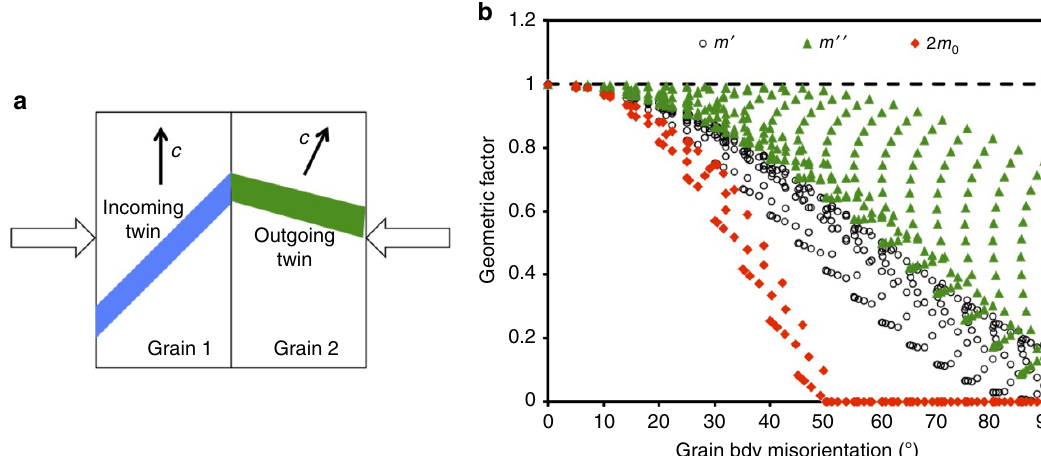
Figure 3 | Characterization of twin transmission using geometric measures. ( a ) Schematic representation of the grains with incoming and outgoing twins with loading direction. ( b ) Geometric factor for twin transmission across grain boundaries for Mg. Three geometric factors are considered: m 0 , m 00 , 2 m 0 . The m 0 quantifies the alignment of the shear direction and plane normal of the incoming and best oriented outgoing twins and it is defined in equation (1). The m 00 only considers the alignment of the shear directions of incoming and best oriented outgoing twins. Finally, 2 m 0 represents twice the Schmid factor of the best oriented twin systems in the neighbouring grain (note: it can be shown that the map for Zr is similar). Note that the Schmid factor for the larger misorientation cases ( 4 B 50 (cid:2) ) can be negative, in which case we assign a zero value to it, to consider only the forward twin shear